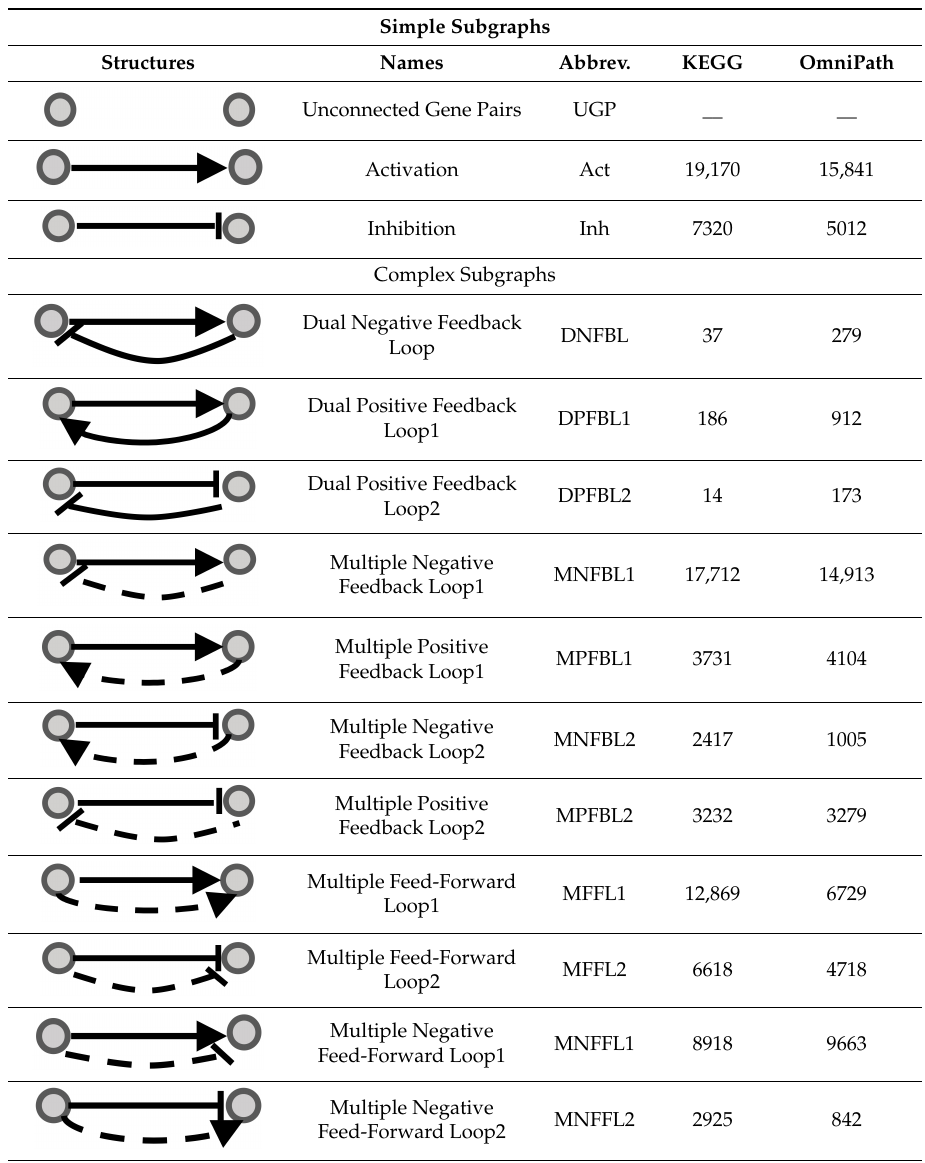
Table 1. Details of di ff erent subgraphs present in all biological signaling networks. The dashed lines indicate multiple edges between nodes. The last two columns provide the number of each subgraph in the two signaling